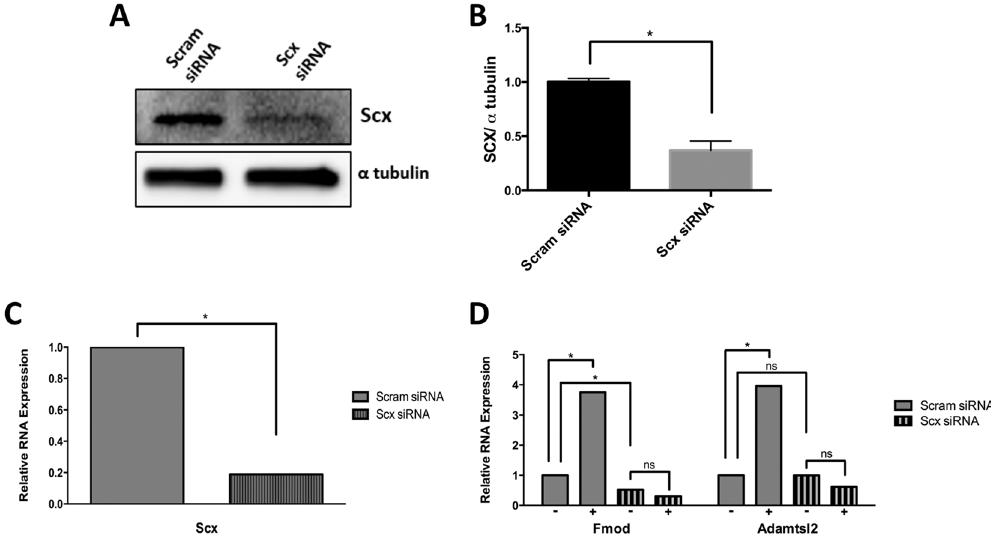
Figure 6. Scx is required for the expression of Fmod and Adamtsl2. ( A ) C 3 H 10 T 1/2 cells were transduced with a scrambled siRNA control (Scram) or Scx specific siRNA for 24 h. Representative immunoblot showing Scx protein. α-tubulin is used as a loading control. ( B ) Quantification of Scx immunoblots comparing Scram transduced and Scx siRNA transduced cells. Protein levels were normalized to α tubulin and quantified using ImageJ and GraphPad Prism, n = 3, (*) indicates significance, p < 0.05. ( C ) Scx mRNA levels were determined by qPCR in Scram transduced and Scx siRNA transduced cells. Data was normalized to Hprt mRNA and analyzed using REST software, n = 6, (*) indicates significance, p < 0.05. ( D ) RNA was collected from cells that were transduced with Scram siRNA or Scx siRNA for 24 h and subsequently either left untreated (−) or treated with TGFβ1(+) for 8 h. Fmod and Adamtsl2 mRNA levels were determined by qPCR. mRNA levels were normalized to Hprt. qPCR data was analyzed by REST software, n = 6, (*) indicates significance, p < 0.05. Detailed results from qPCR REST analysis are shown in Tables S11, S12. Immunoblots were cropped for clarity. Examples of uncropped blots are found in Supplementary